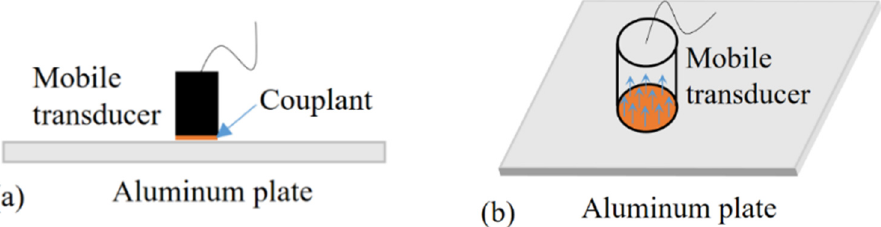
Figure 3. Illustration of the operating principle of the mobile transducer: ( a ) coupling of the mobile transducer and the plate; ( b ) sensing principle of the mobile transducer.